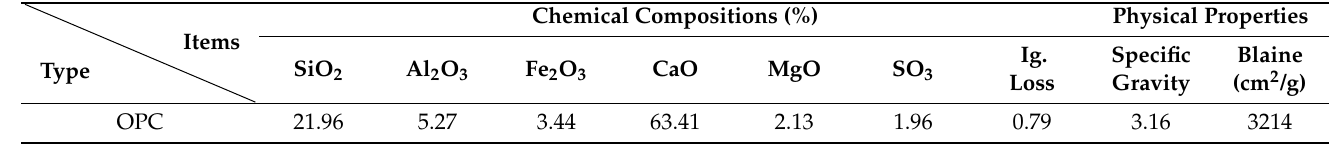
Table 2. Chemical and physical properties of ordinary Portland cement (OPC).